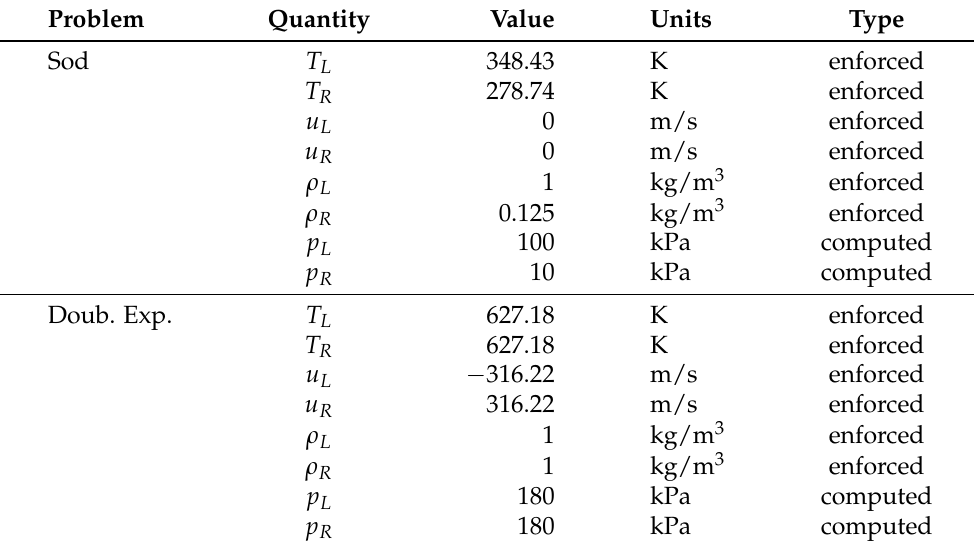
Table 3. Ideal gas Riemann problems initial